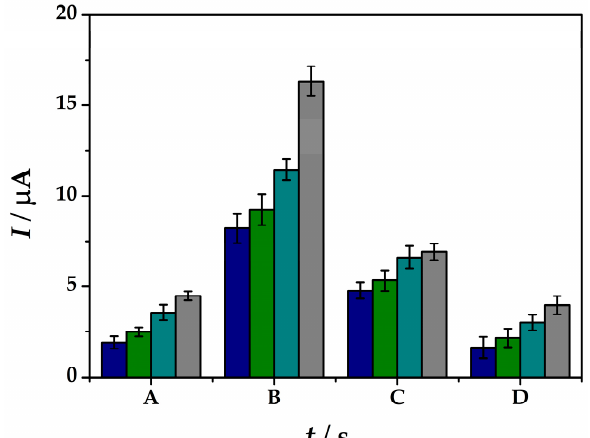
Figure 5. Peak current intensities obtained by means of SWASV measurements at ( IV )Au-PtNPs / SPCE from solutions containing As(III) of 33 nM (blue), 67 nM (green), 133 nM (cyan), 200 nM (grey) in 0.1 M HCl (iii) by applying a cathodic pre-concentration time ( t dep ) of 60 s (A), 120 s (B), 180 s (C), 240 s (D) at E dep = − 0.50 V.